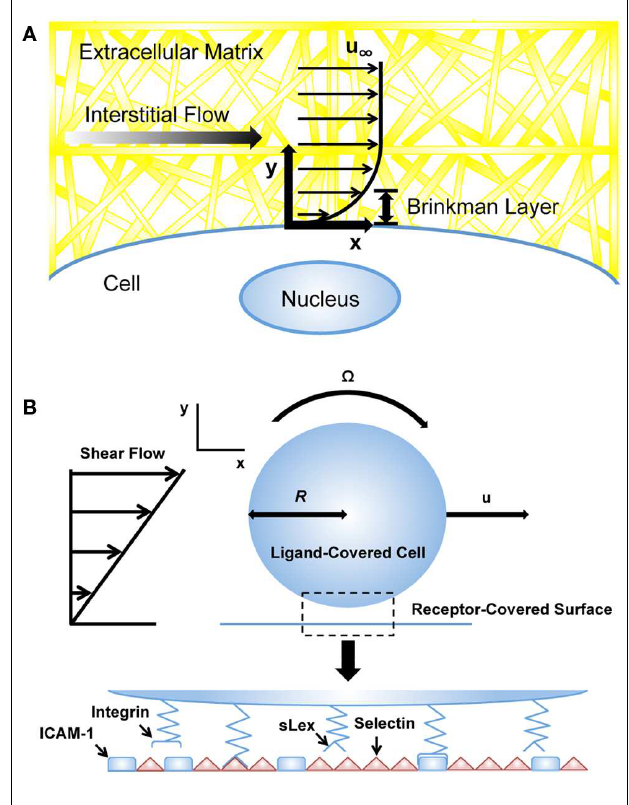
FIGURE 2 | Computational models of cells exposed to blood and interstitial flows. (A) Computational models utilizing the Brinkman equation to estimate interstitial flow-generated shear stresses on the cell surface (Tarbell and Shi, 2012). u ∞ : velocity far from cell surface. (B) Adhesive dynamics (AD) simulations to predict selectin-mediated adhesion to the endothelium (Bhatia et al., 2003). u , velocity; R , cell radius; sLex, sialyl-Lewis-x; ICAM-1, intercellular adhesion